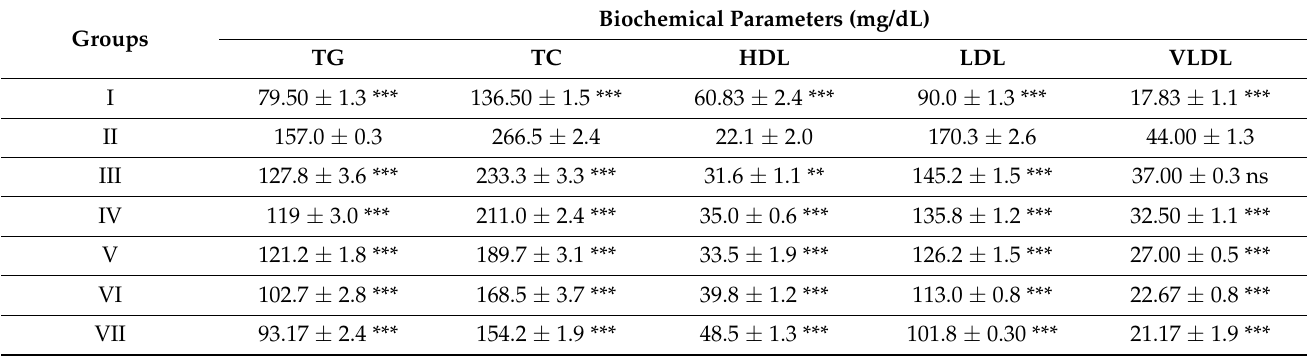
Table 5. Effects of TPE and TPE-ZnO NPs on blood lipid levels (md/dL) in STZ-induced diabetic rats.